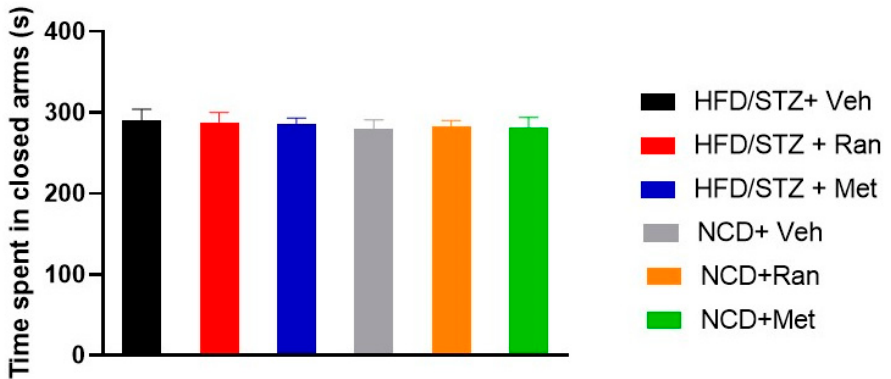
Figure 8. Elevated plus maze (EPM). Bars indicate the time spent in closed arms (s). Data values are